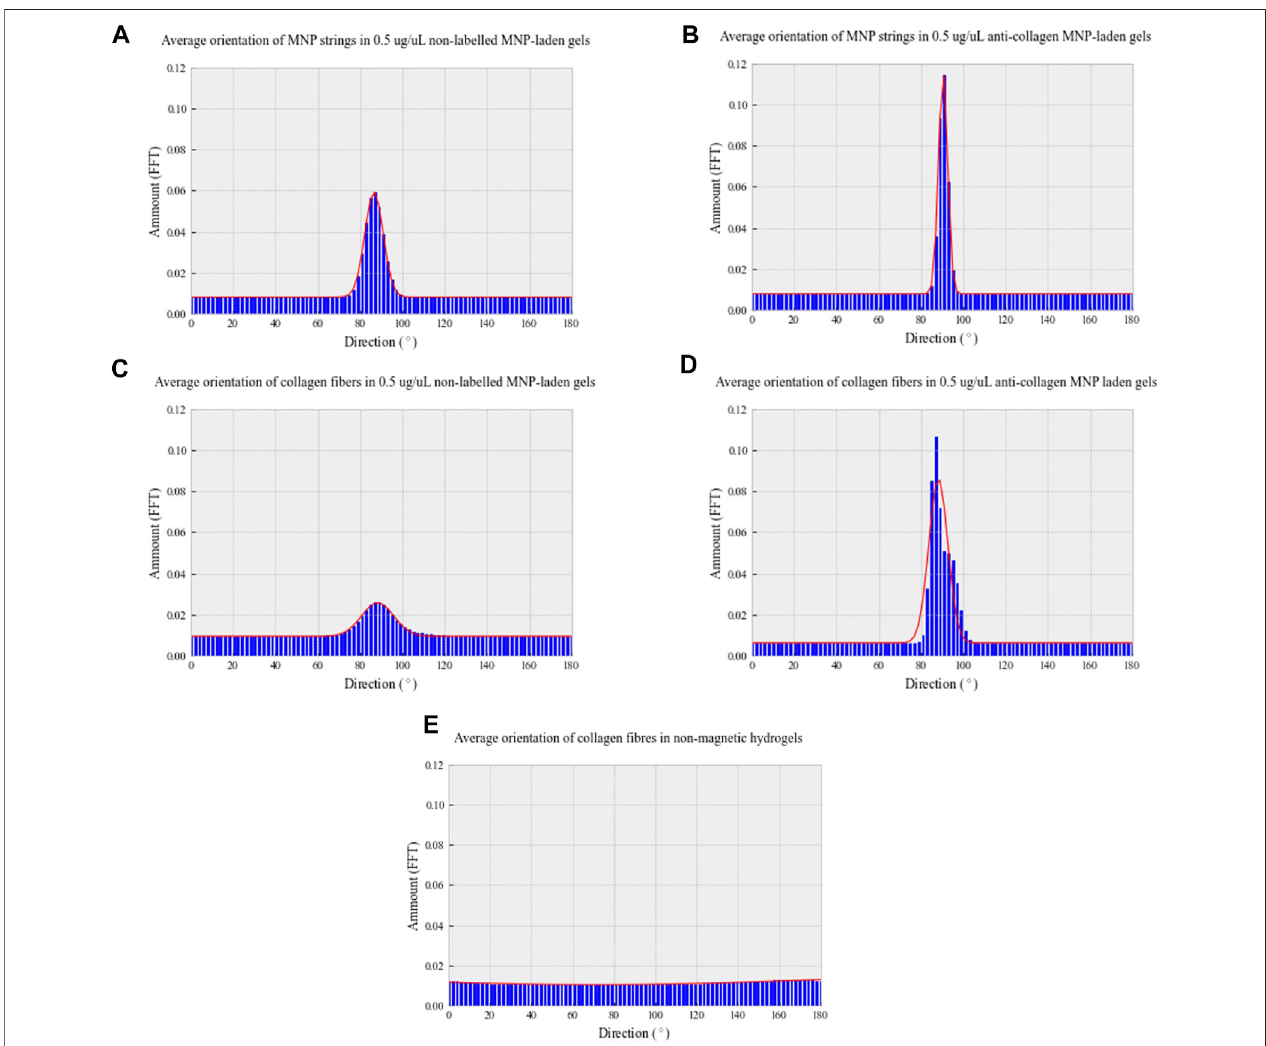
FIGURE4| Directionalitydistributionhistogramsof0.5 μ g/ μ lnon-labeledMNPstrings (A) and fi ber-likecollagenstructures (C) ;0.5 μ g/ μ lanti-collagenMNPstrings (B) and fi ber-likecollagenstructures (D) ;non-magnetic (E) collagengels.Allgelswereexposedtoa30-minmagnetic fi eld (E) .TodetermineMNPand fi ber-likecollagen structure alignment, light microscopy and confocal microscopy images, respectively, were analyzed with Directionality plug-in of ImageJ in Fourier spectrum analysis mode. n = 3, trendline = fi t to the Gaussian function.